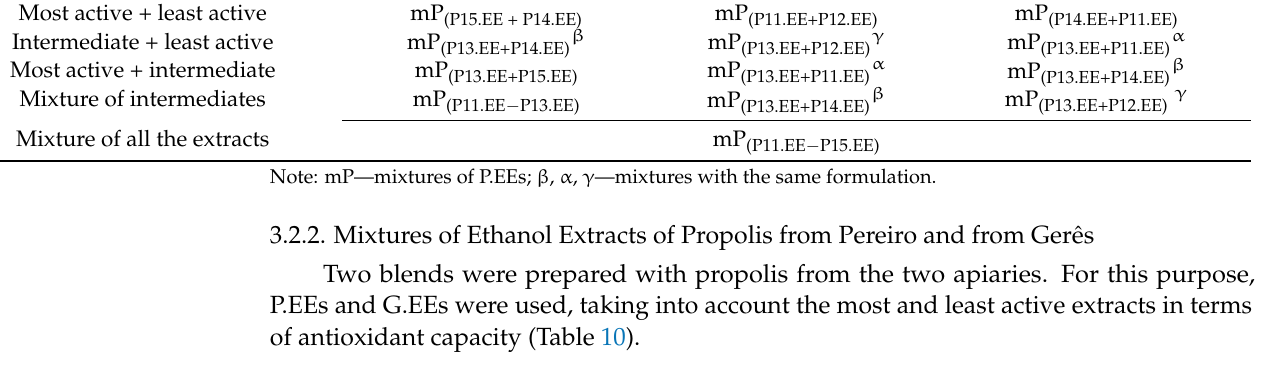
Table 10. Mixtures of ethanol extracts of propolis from Pereiro (P) and from Ger ê s (G) prepared with the most and least active extracts of each apiary regarding antioxidant potential. Criteria Underlying the Mixtures